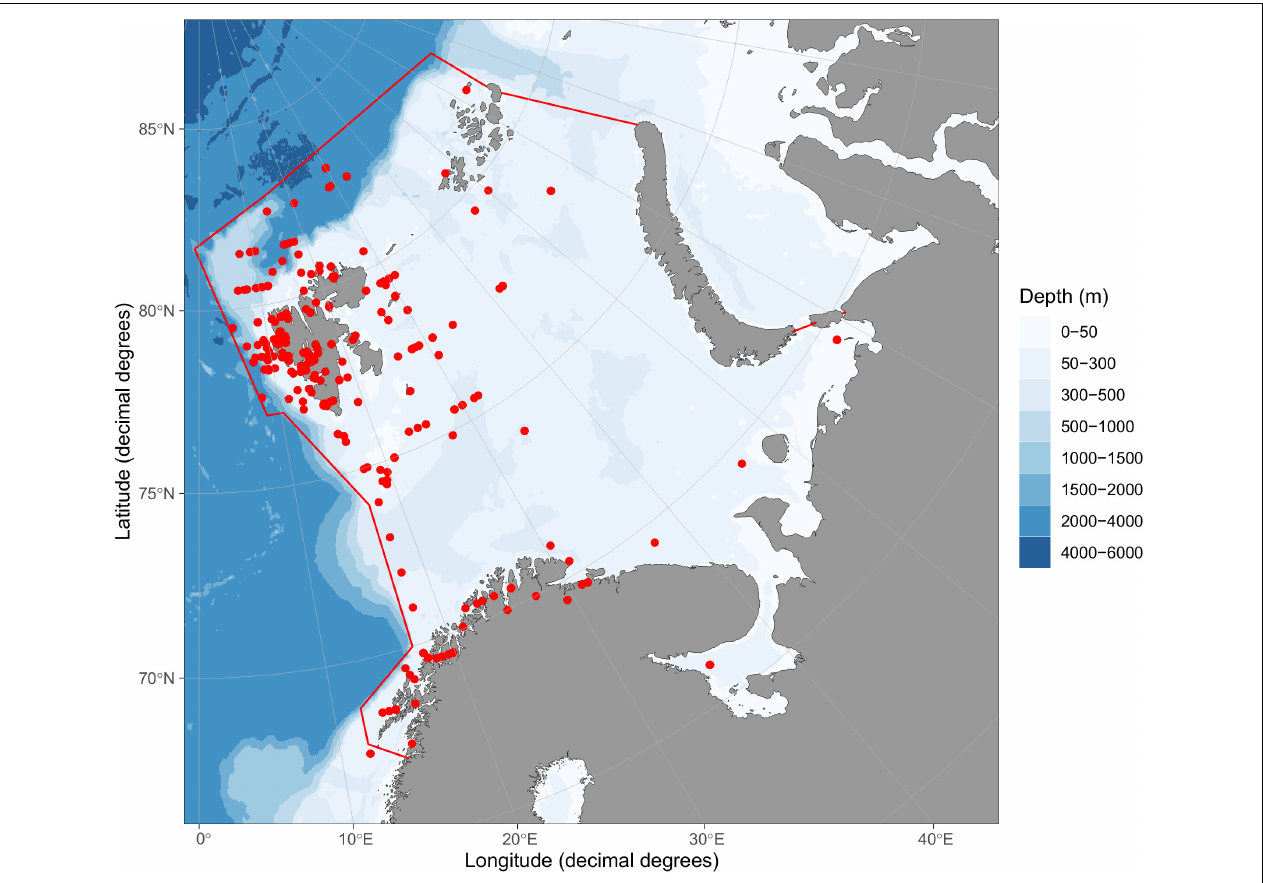
FIGURE 1 | Map of Barents Sea large marine ecosystem. Borders of the ecosystem are shown by red lines based on https://www.pame.is/projects/ecosystem-approach/arctic-large-marine-ecosystems-lme-s. Positions for sampling of data entries are shown by red dots. Map was created using R-package ggOceanMaps (Vihtakari,